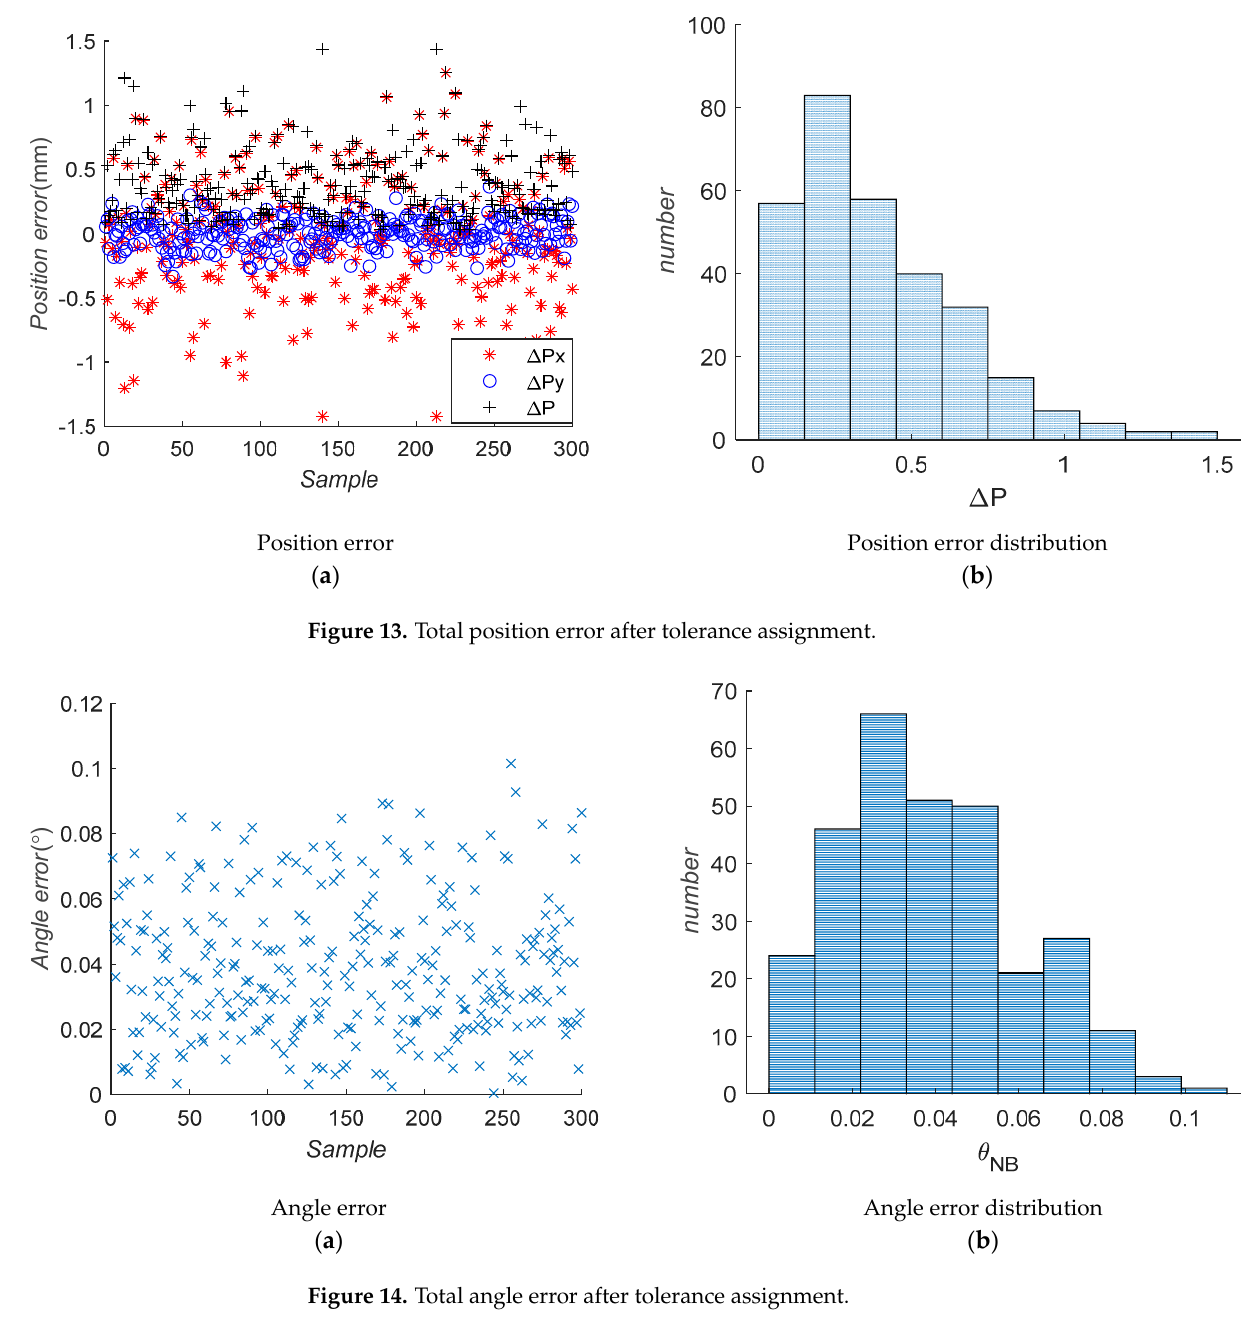
Figure 14. Total angle error after tolerance assignment.